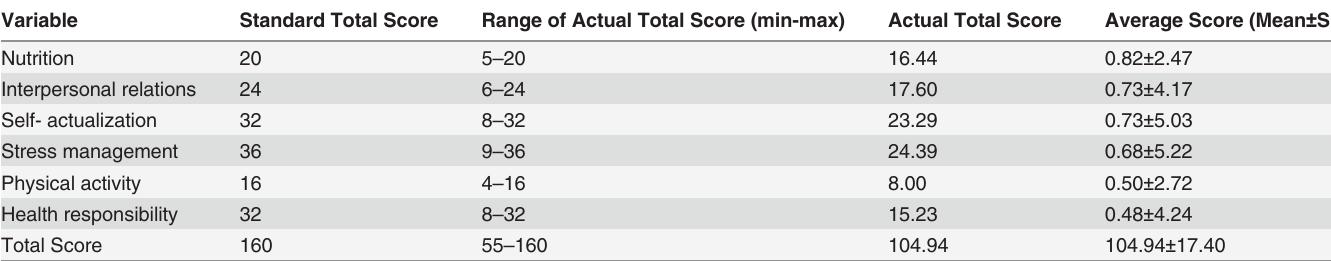
Table 2. Score of HPLP-C subscales (n = 954).